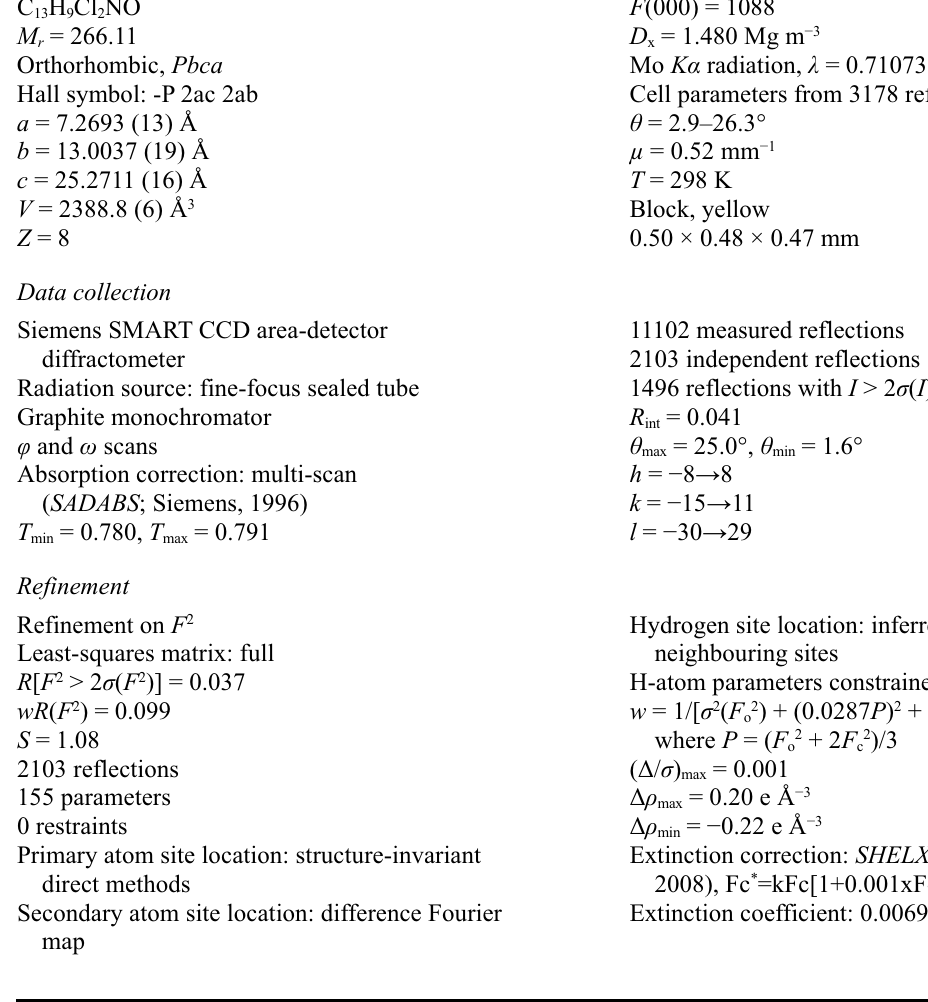
Figure 1 The structure of the title compound with 30% probability ellipsoids. The dashed line represents hydrogen bond. 4-Chloro-2-[( E )-(2-chlorophenyl)iminomethyl]phenol Crystal